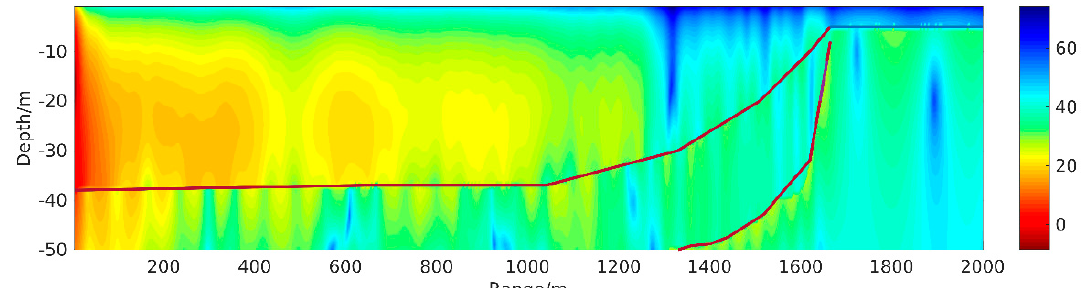
Figure 10. Spatial distribution of hydroacoustic energy from the transmitter to the coast along the receiving stations.